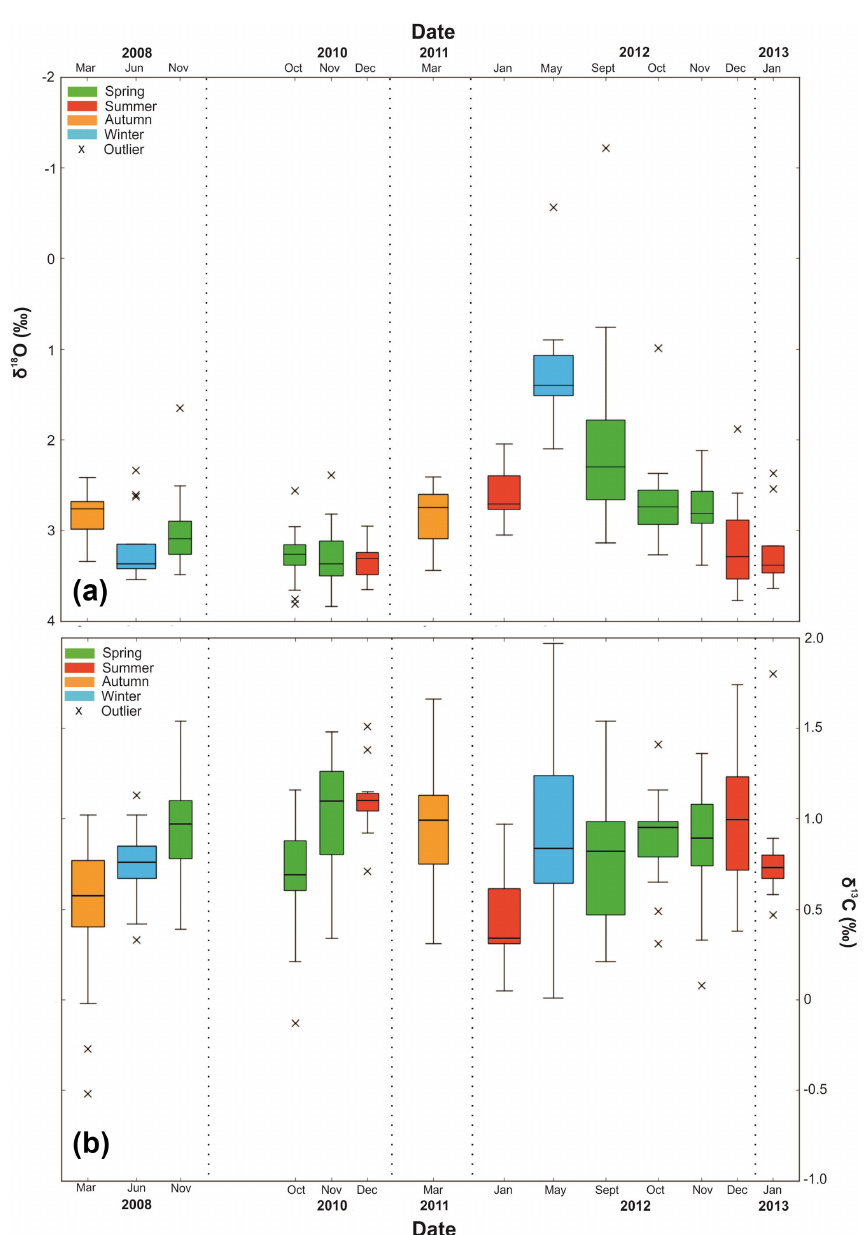
Figure 7. Boxplot of single-specimen (a) δ 18 O np and (b) δ 13 C np (VPDB). Crosses represent outliers defined by interquartile range (hori- zontal line represents median). Dashed lines are visual divisions between the years. The width of each box represents the length of time that the collection cup was open in the sediment trap; the thinnest box is 7d, and the widest box is